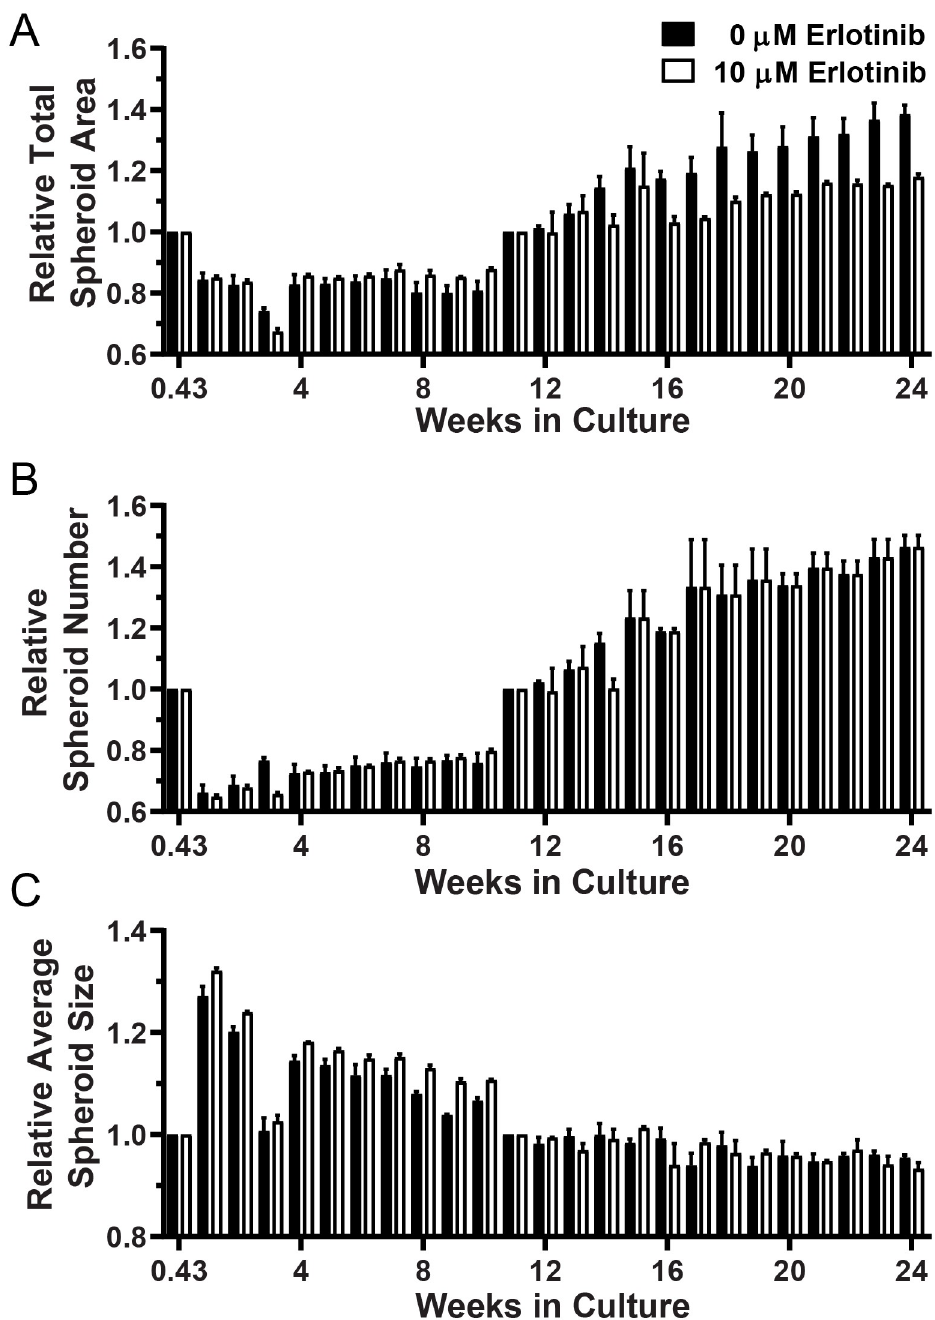
Fig 4. Long-term culture and growth parameters for Tumor 14. (A) Total spheroid area (measured in Px), (B) spheroid number, and (C) average spheroid size measured at Day 3 (0.43 weeks) and after passage at Week 10 were set to 1 for each well and relative repeat measures over time are